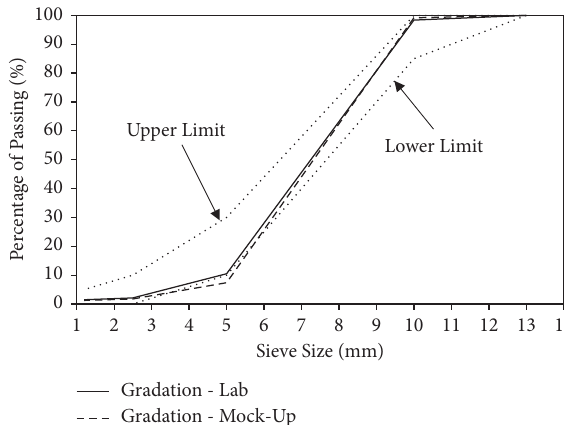
Figure 1: Aggregate gradations for laboratory and mock-up test.